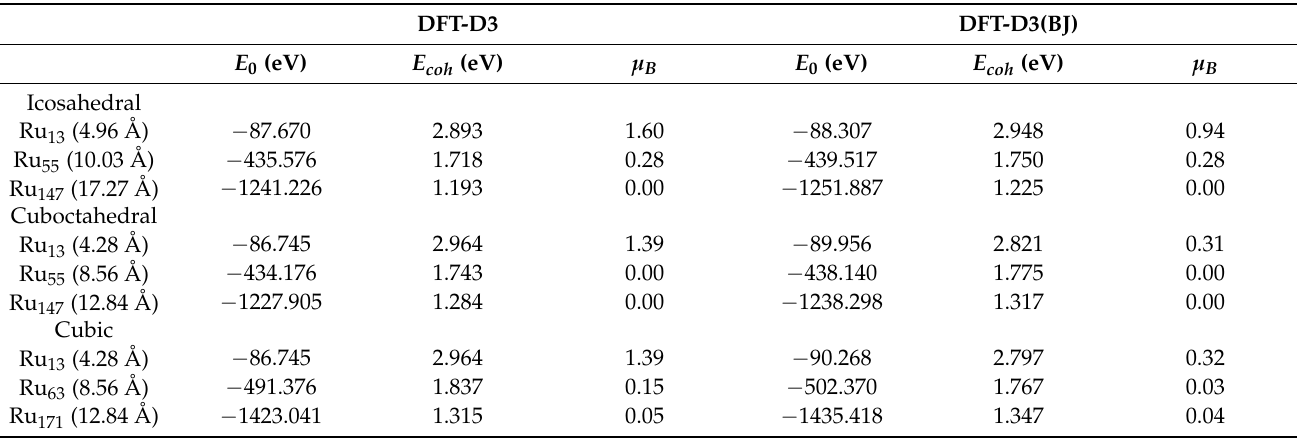
Table 1. Total energy ( E 0 ), cohesive energy ( E coh ) and magnetic moment ( µ B ) for the fcc Ru icosahedral, cuboctahedral and cubic nano-dots of increased sizes with two modelling methods, DFT-D3 and DFT-D3(BJ),